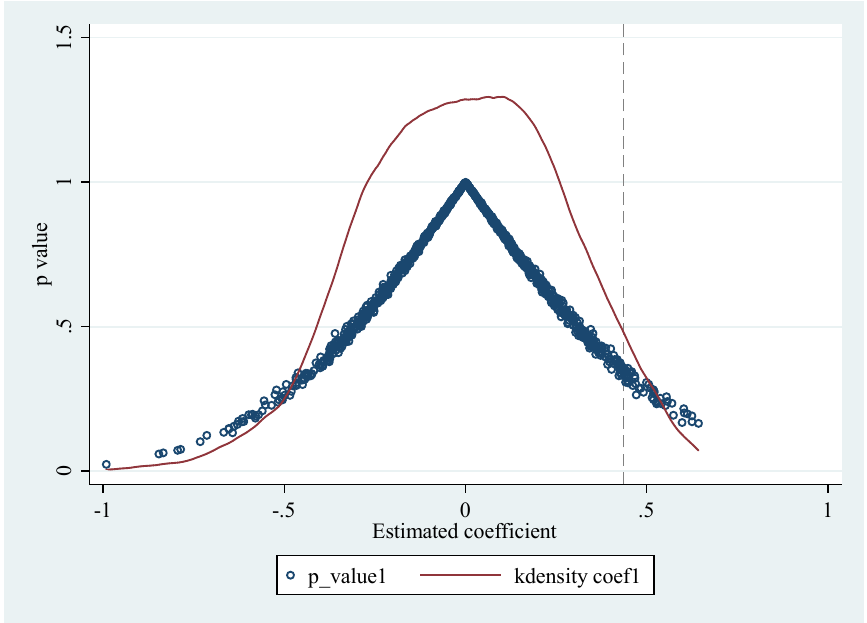
Figure 4. Kernel density estimate.